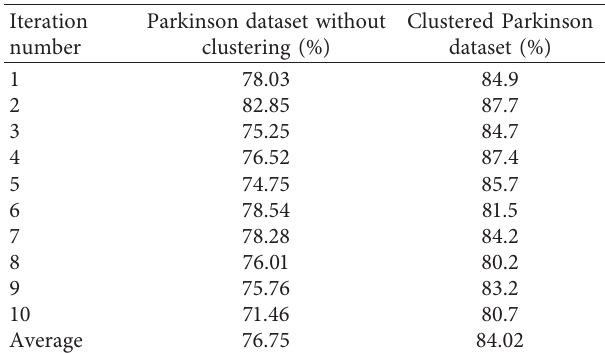
average Table 3: The overall accuracy of applying the model on the dataset with/without clustering on the PD